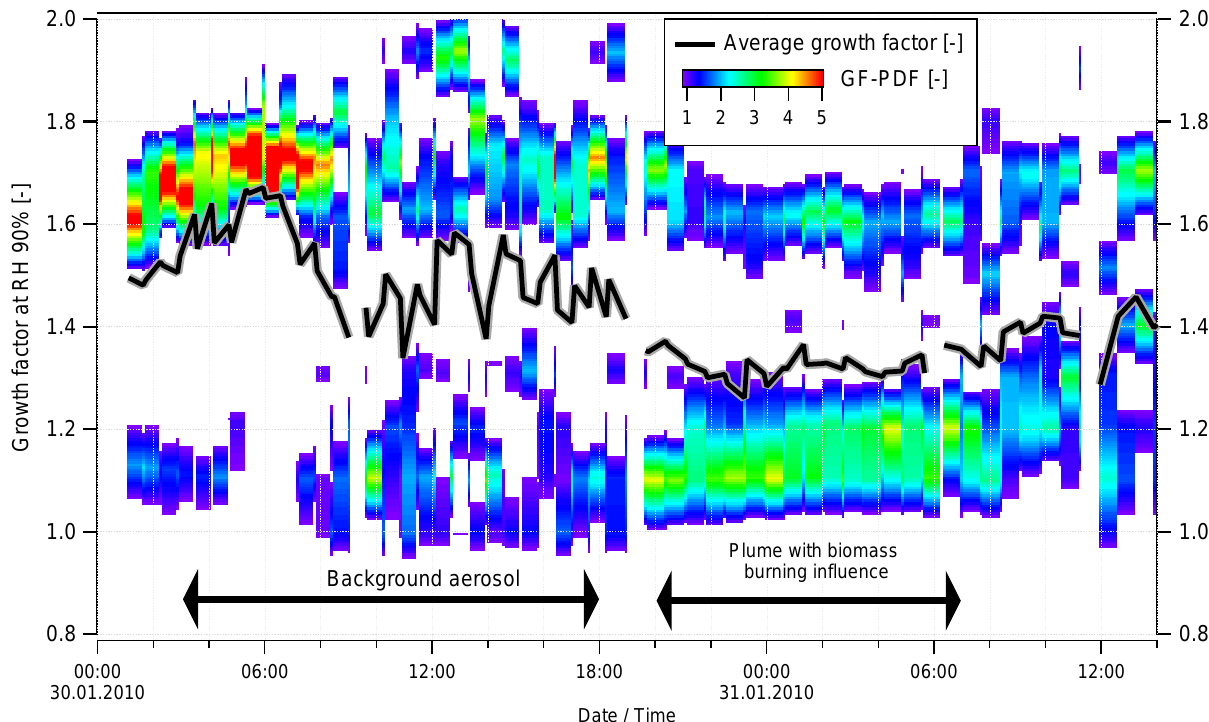
Fig. 14. GF-PDF at 90% RH and D 0 = 265nm during the period when the coupled HTDMA-SP2 setup was used. Two distinct periods with dominant influence from background aerosol and biomass burning are indicated by the black